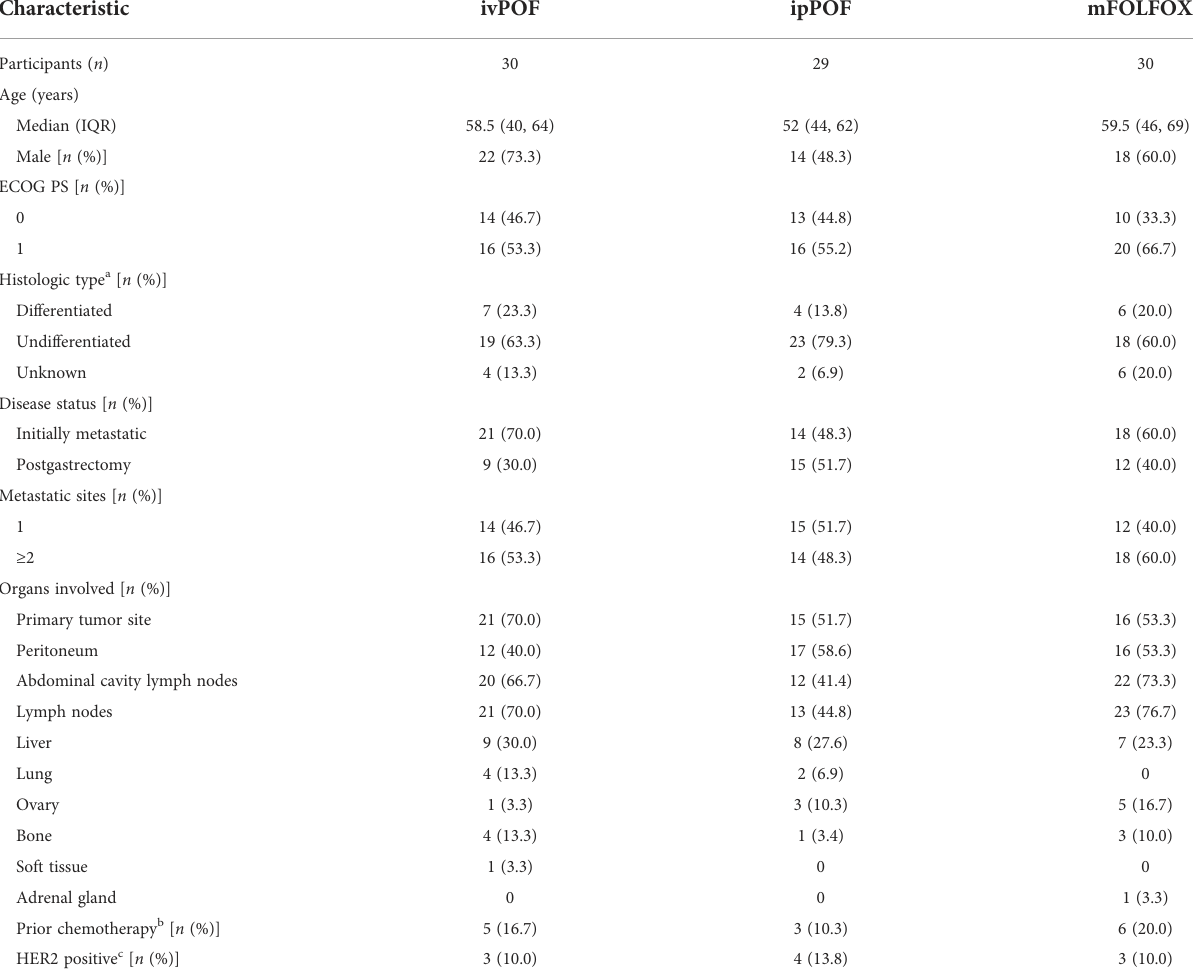
TABLE 1 Patient demographics and baseline